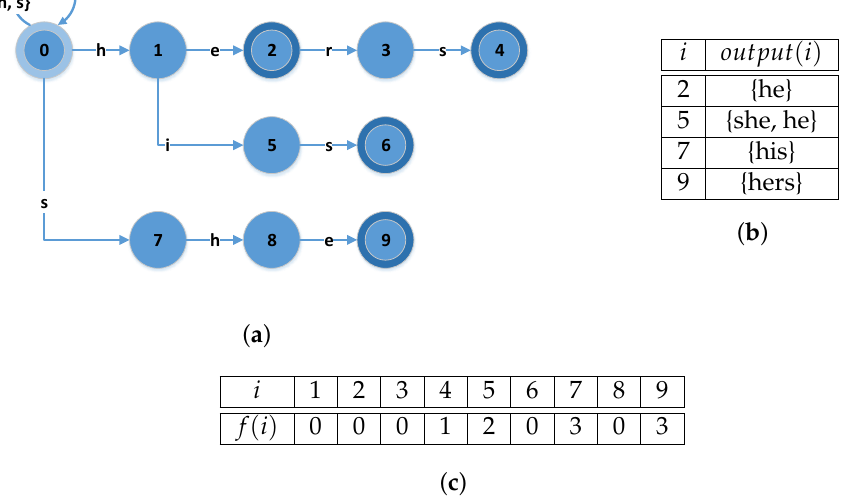
Figure 2. An example of multi-pattern matching with Aho–Corasick. ( a ) The Aho–Corasick goto function, presented as a state machine for the patterns she, he, hers, his. ( b ) The output function, indicating the final state of each pattern in the given set. ( c ) The Aho–Corasick failure function for the given pattern